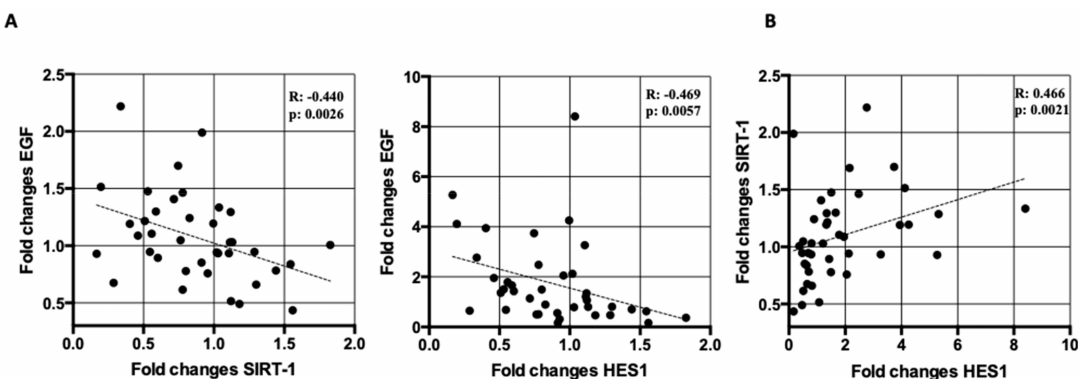
Figure 4. Correlation analyses. ( A ) Correlation between changes in SIRT1 and HES1 mRNA expression levels and changes in serum levels of Epidermal Growth Factor (EGF). Correlations were assessed by Spearman’s correlation test ( HES1 , R = − 0.469, p < 0.01; SIRT1 , R = − 0.440, p < 0.01). ( B ) Correlation betweenchangesin HES1 and SIRT1 mRNAexpressionlevels. CorrelationswereassessedbySpearman’s correlation test (R = 0.466, p < 0.01). SIRT1 and HES1 changes were defined as ratio between mRNA levels after (T30) and before (T0) treatment with ticagrelor or clopidogrel. EGF changes were expressed as ratio between serum EGF concentration at T30 over serum EGF concentration at